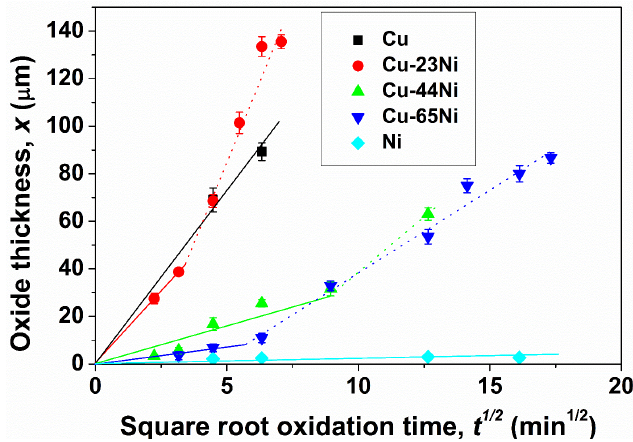
Figure 1. Oxide thickness as a function of the square root of oxidation time at 1173 K for Cu (black squares), Cu-23Ni (red circles), Cu-44Ni (green up triangles), Cu-65Ni (blue down triangles) and Ni (cyan diamonds) samples. In the case of pure elements, experimental points were fitted with a single parabolic law (continuous lines), 𝑥 = √𝐾 𝑝 𝑡 , where x , t and K p are the oxide thickness, the oxidation time and the parabolic rate constant, respectively. In the case of Cu-Ni alloys, experimental points show the presence of two steps (continuous and dotted lines, respectively). For Cu-23Ni and Cu-65Ni samples, each step was fitted with a parabolic law, leading to different values of the constant rate, K p ′ and K p ′′ , as reported in Table 1. Table 1. Values of the parabolic rate constants at 1173 K for oxidation of Ni, Cu-65Ni, Cu-44Ni, Cu-23Ni and Cu samples. K p ′ and K p ′′ values are related to the first oxidation step (present in all the samples) and the second oxidation step (present only in the Cu-Ni alloys), respectively.